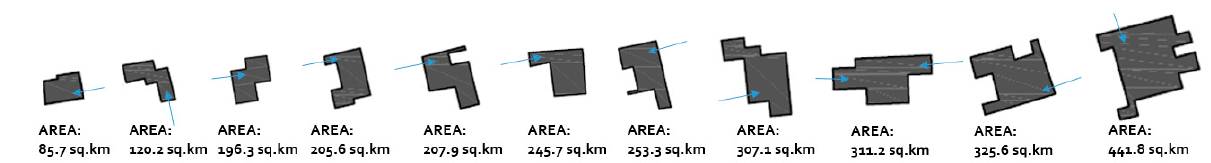
Figure 13. Courtyard forms are arranged according to areas. Entry points are marked in blue arrows.